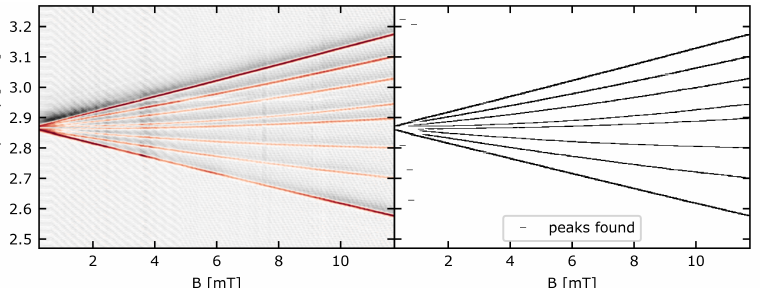
Figure A4. Peak finding in ODMR spectra in order to deduce the frequency values of the intensity dips. Note that for spectra below 1.5 mT, peak finding is not reliable due to the superposition of multiple intensity dips. The total magnetic field magnitude is then calculated using